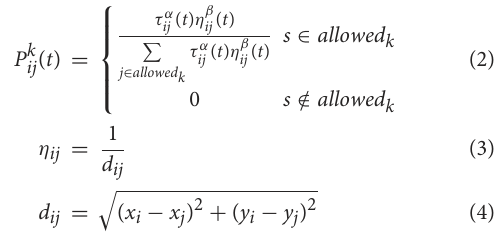
FIGURE2 Grid coordinate diagram.